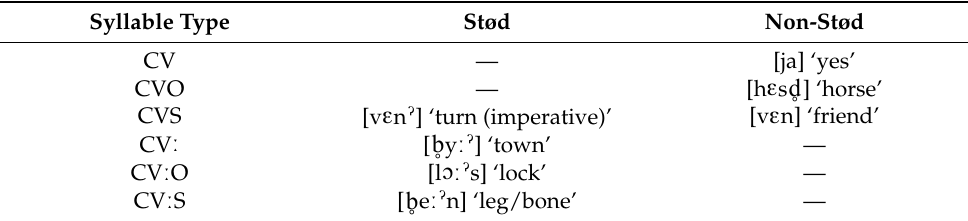
Table 2. Distribution of stød-bearing and stød-less syllables in monosyllabic Danish words. ‘—’ indicates illegal syllabic configurations in Standard